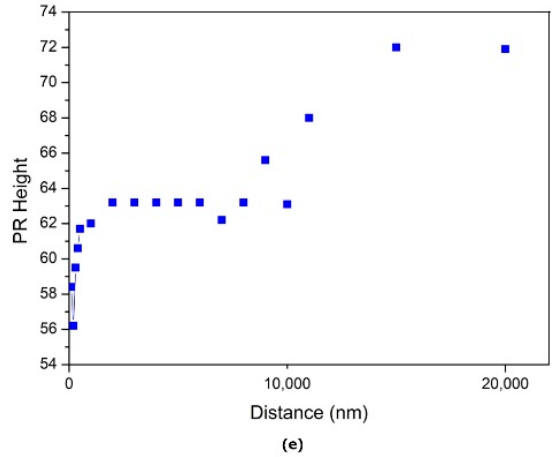
Figure 6. Cross-section image of PR according to the distance of the shot field (PR height difference due to flare intensity), ( a ) Stitching cross-section SEM, ( b ) LFE 0~500 n distance section, ( c ) normal PR height, ( d ) LFE 9 μ m distance section, and ( e ) PR height according to LFE distance.